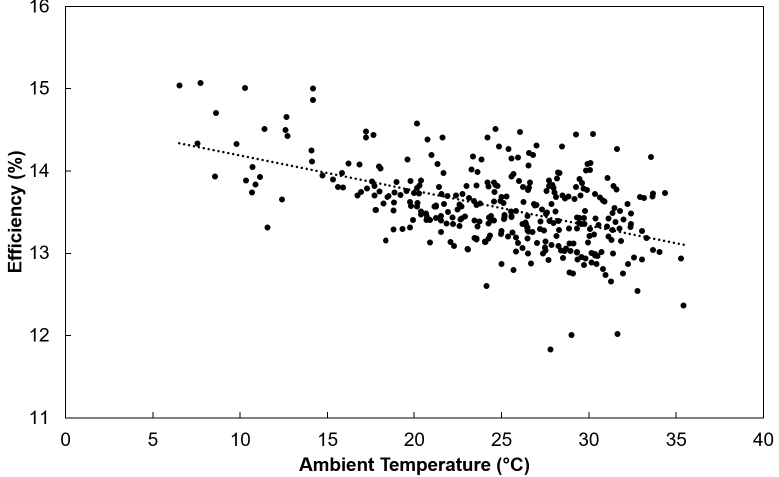
Figure 9. Relationship between PV array efficiency and ambient